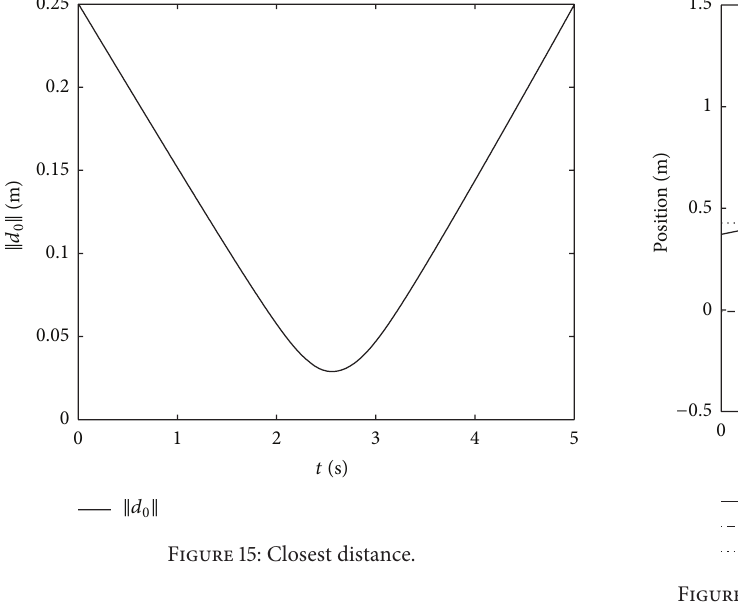
Figure 17: The changes of the position of the end-effector.